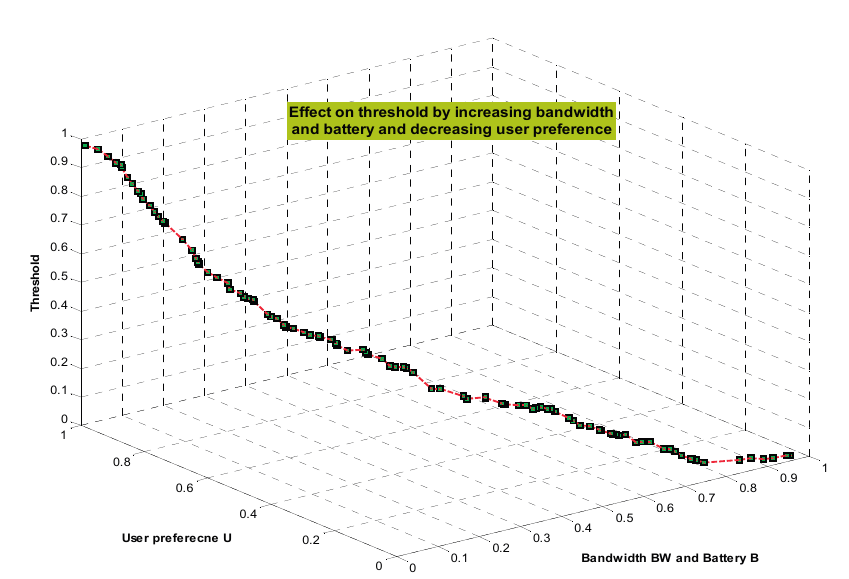
Figure 6. The combined variational impact of smartphone resources and user preference on threshold τ